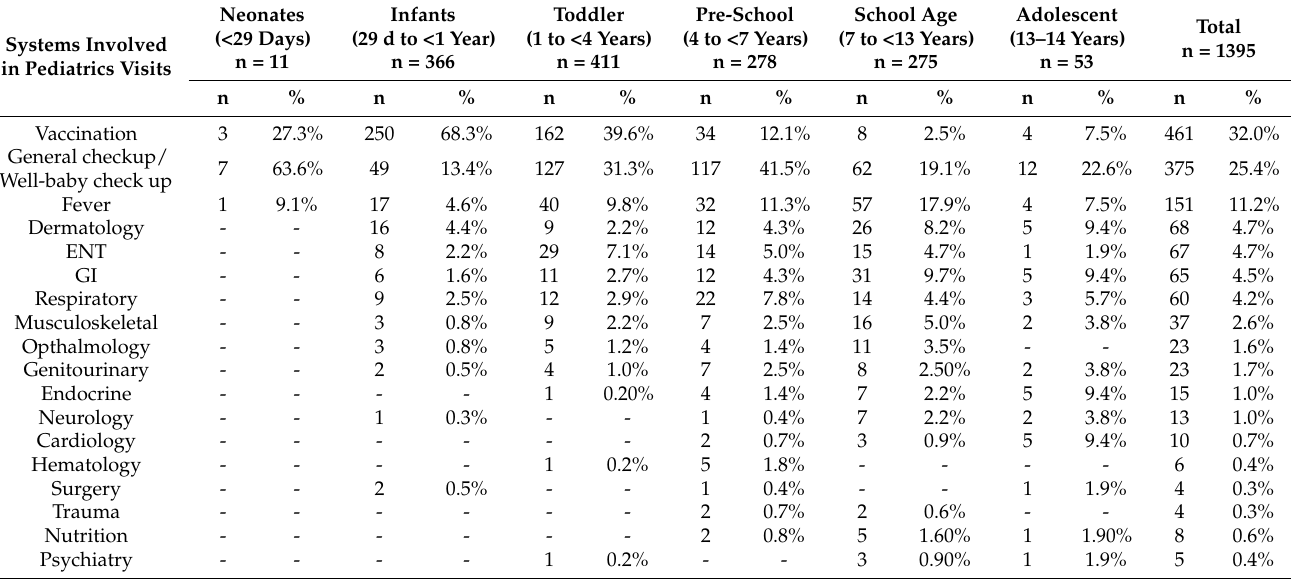
Table 2. Systems involved in main complaints of pediatric visits to PHC according to age.